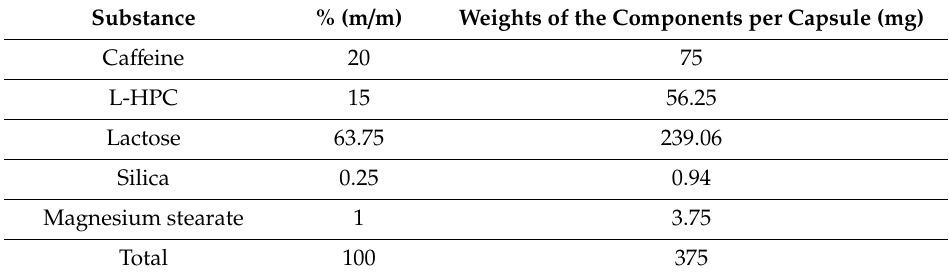
Table 1. Formulation of the capsule filling. All values (%) are based on the total weight (m / m).